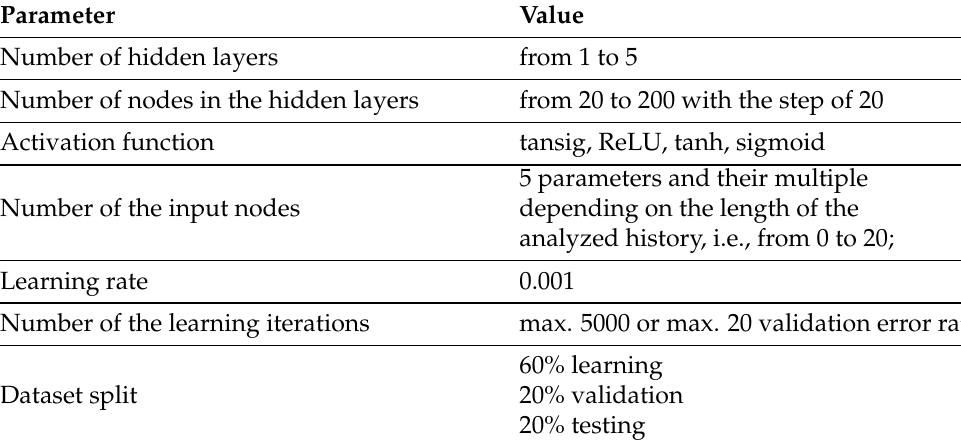
Table 3. The hyperparameter variability and the learning parameters in the first stage of the learn- ing